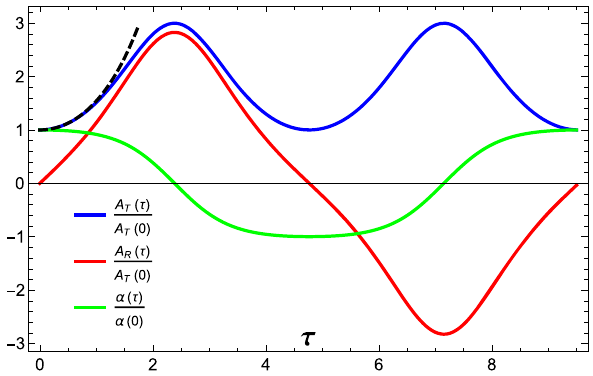
Fig. 2 Plot corresponding to the solution of Eqs. (6), (7) and (8) as a function of the dimensionless parameter τ = gm a α( 0 ) t / 2 and ini- tial conditions A T ( 0 ) = α( 0 )/ 2 and A R ( 0 ) = 0. The time dependent amplitudes A T and A R are normalized by A T ( 0 ) while α is normalized by α( 0 ) . The dashed black line corresponds to A T in the linear